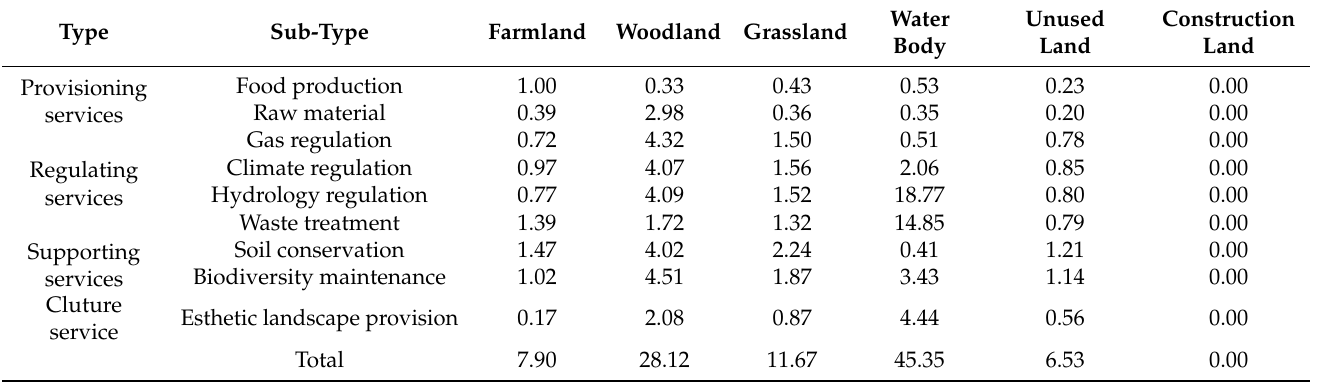
Table 2. Equivalent value per unit area of ecosystem services in China (yuan/hm 2